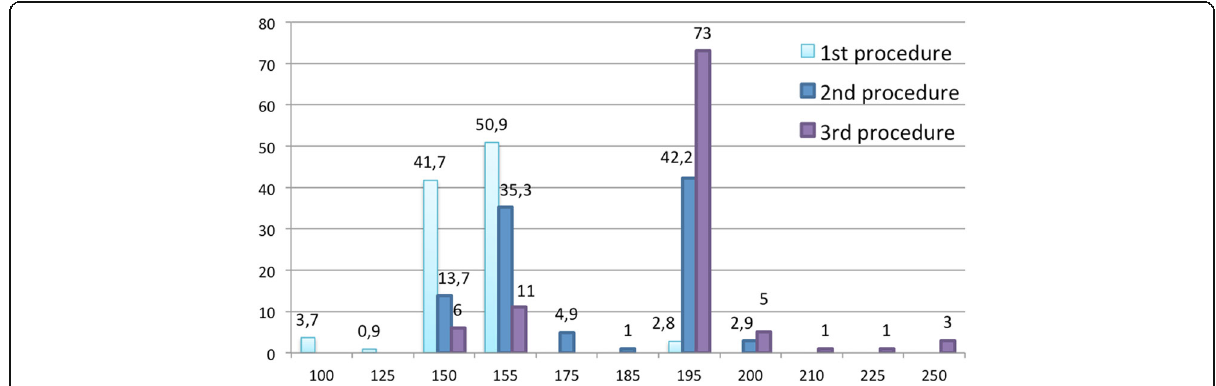
Fig. 6 Percentage of participants that administer each defined number of OnabotA units per procedure. Light blue represents the first procedure, dark blue the second procedure and purple the third procedure